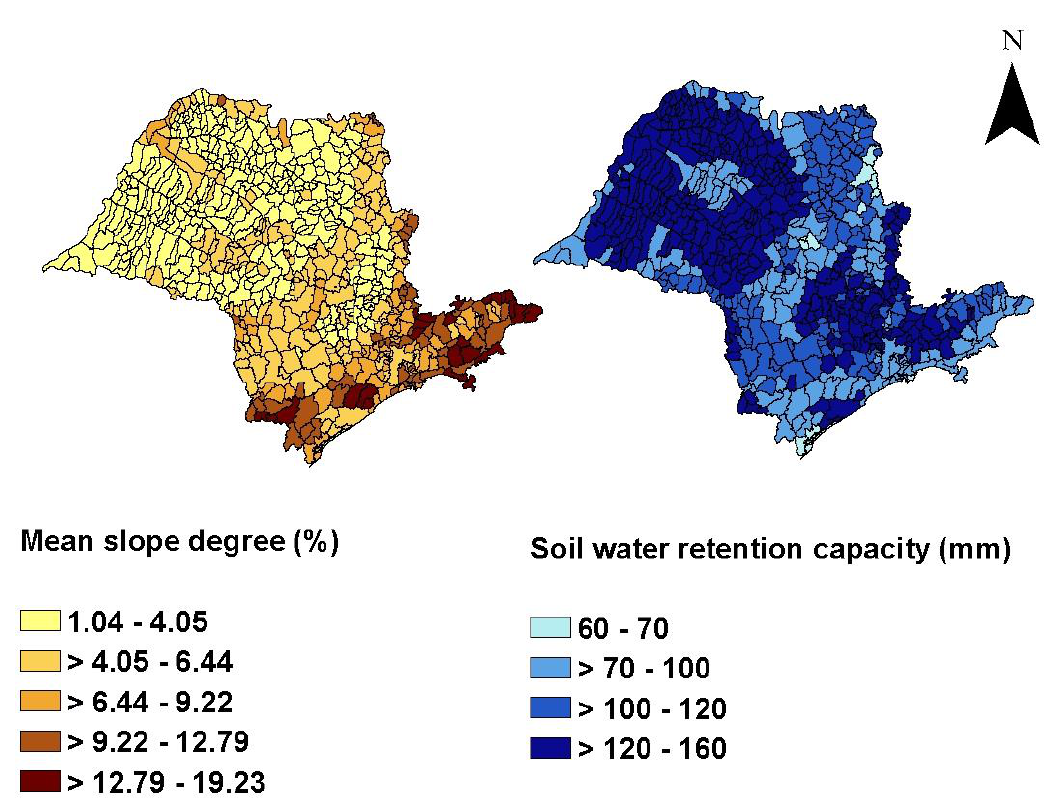
FIGURE A1.10 Soil water retention capacity and mean slope degree at the municipality-scale for the state of São Paulo. Municipality boundaries are shown in